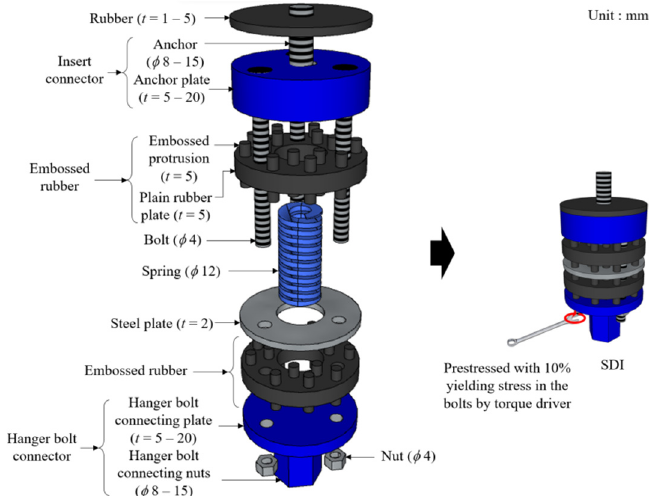
Figure 9. Optimal schematic for SDI.